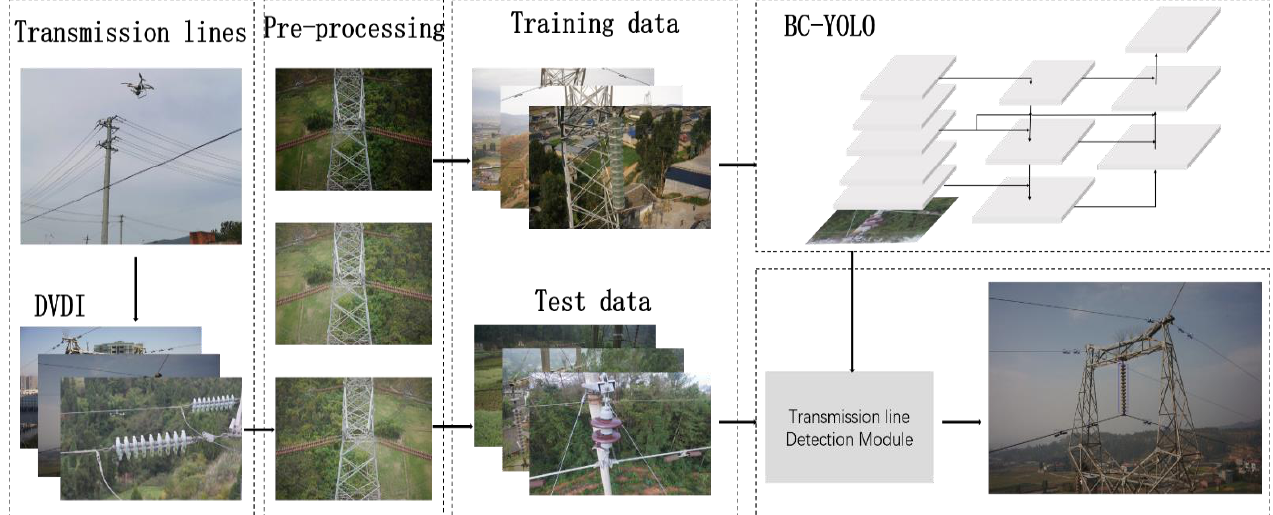
Figure 13. Schematic diagram of the proposed framework for insulator and vibration damper defect detection.